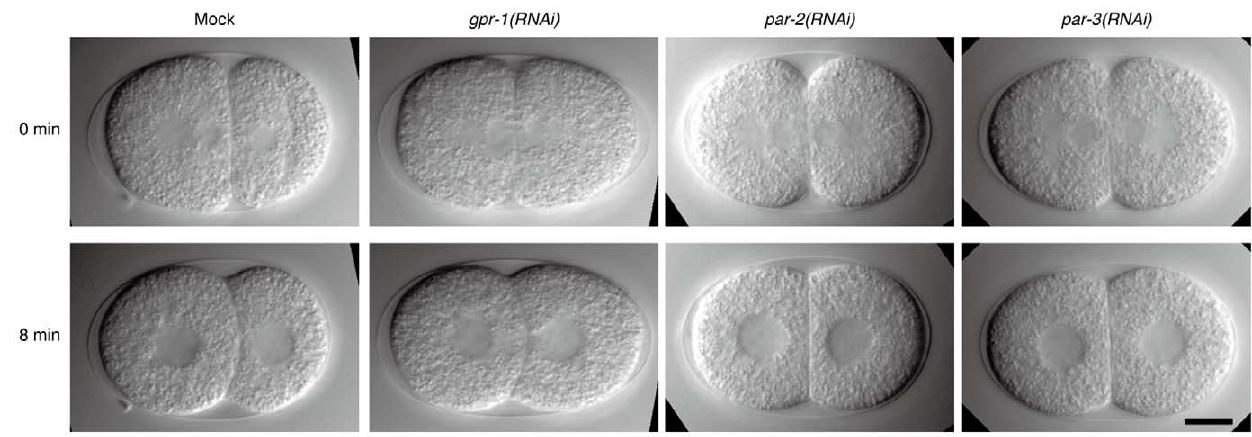
Figure 7. Cell size manipulation confirmed that the ratio of cell size is not the determinant of the pressure difference. DIC images of RNAi embryos. Time is from the onset of the two-cell stage. Cell size symmetry was judged at 0 min. Scale bars, 10 m